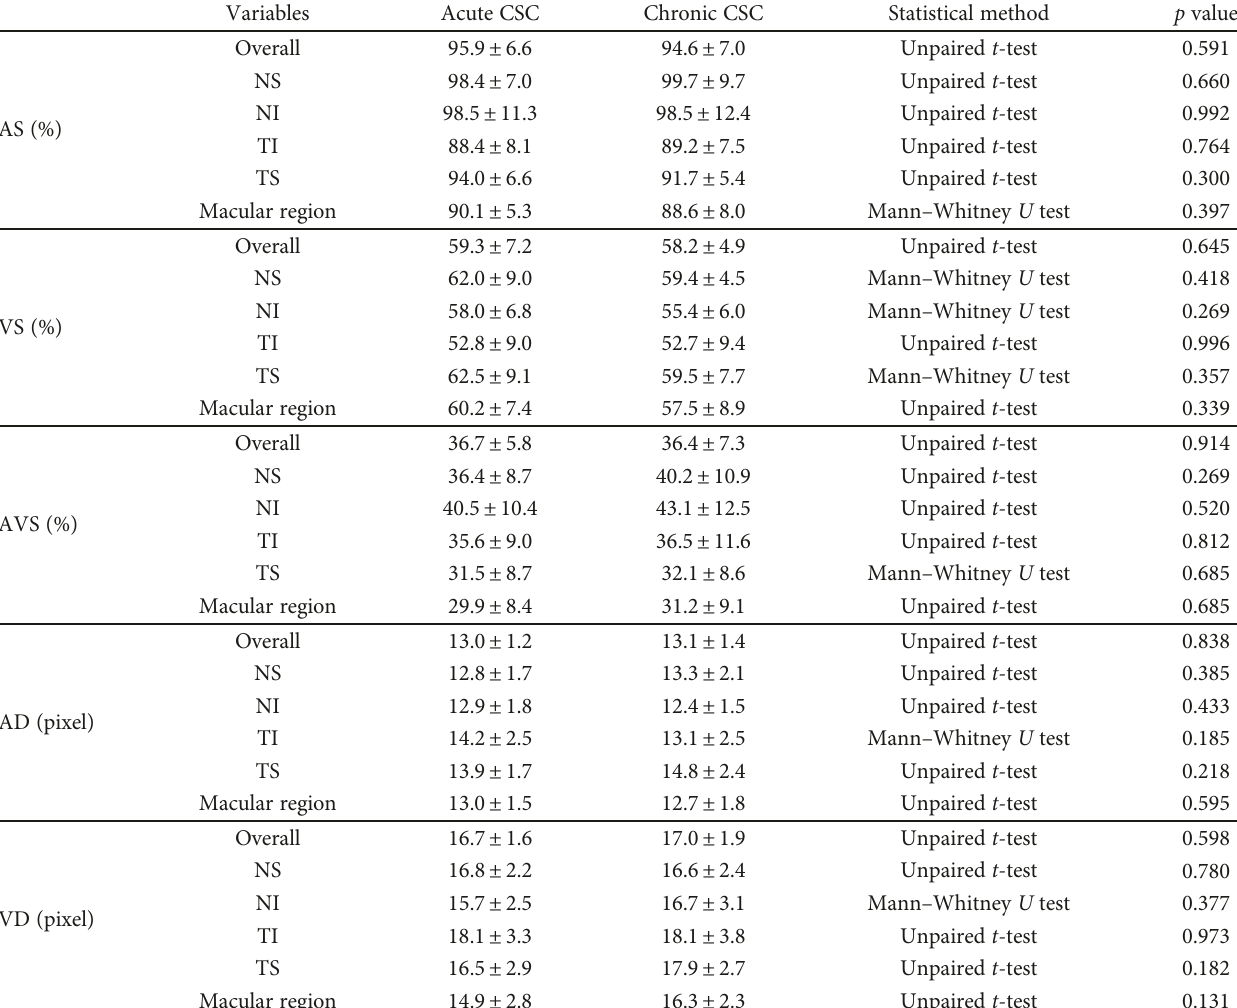
Table 4: Comparison of oxygen saturation and vessel diameter of the contralateral eyes between acute and chronic CSC